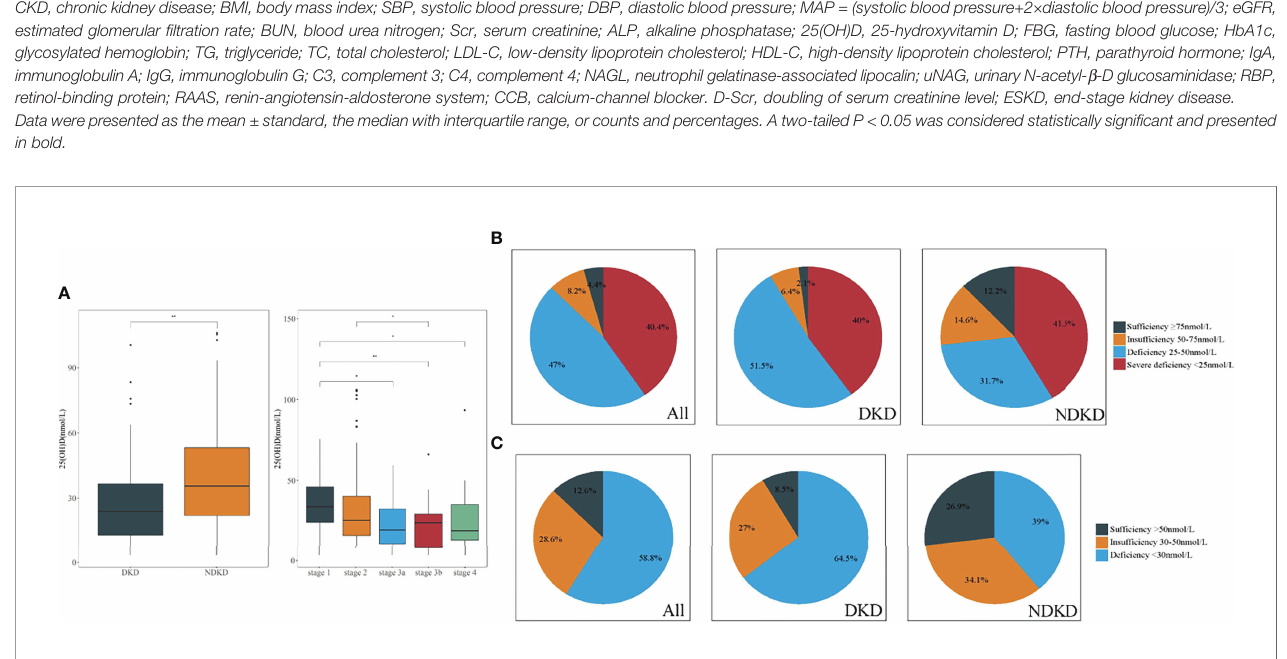
FIGURE 2 | Comparison of vitamin D levels in patients with DKD and NDKD. (A) Signi fi cant difference was obtained in vitamin D levels between DKD and NDKD, in different stages of CKD, respectively. (B, C) . Vitamin D status in all patients with DKD and NDKD, respectively. (B) Four categories according to the Endocrine Society clinical practice (ESC) guidelines and the UK Scienti fi c Advisory Committee on Nutrition (SACN). (C) Three categories according to the Institute of Medicine (IOM). * P < 0.05 between all groups. ** P < 0.01 between groups. DKD, diabetic kidney disease; NDKD, non-diabetic kidney disease; 25(OH)D, 25-hydroxyvitamin